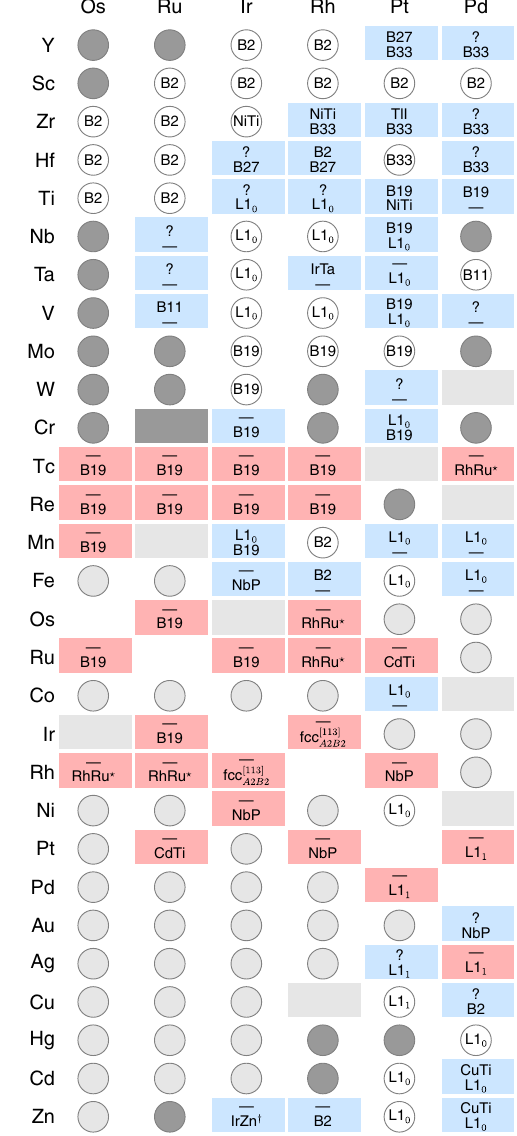
FIG. 2. A Pettifor-type structure map for 1:1 stoichiometry compounds in PGM binary systems. Circles indicate agreement between experiment and computation: White circles with Strukturbericht or prototype labels denote 1:1 compounds, dark circles indicate a compound-forming system with no compounds at 1:1 , and light circles denote non-compound-forming systems. Blue rectangles denote compound-forming systems where the reported and computed stable structures differ at 1:1 stoichiome- try. The top label in the rectangle is the reported structure; the bottom label is the structure we find to be stable in this work. A dash ‘‘—’’ indicates the absence of a stable structure. Unidentified suspected structures are denoted by a question mark. Pink rec- tangles indicate systems reported as non-compound forming, with a dash at the top of the rectangle, but we find a stable 1:1 phase, identified at the bottom of the rectangle. Light gray rectangles indicate systems reported as non-compound forming where a structure is predicted at a stoichiometry different from 1:1 . A dark gray rectangle indicates a system reported with a disordered compound where no stable structures are found in the